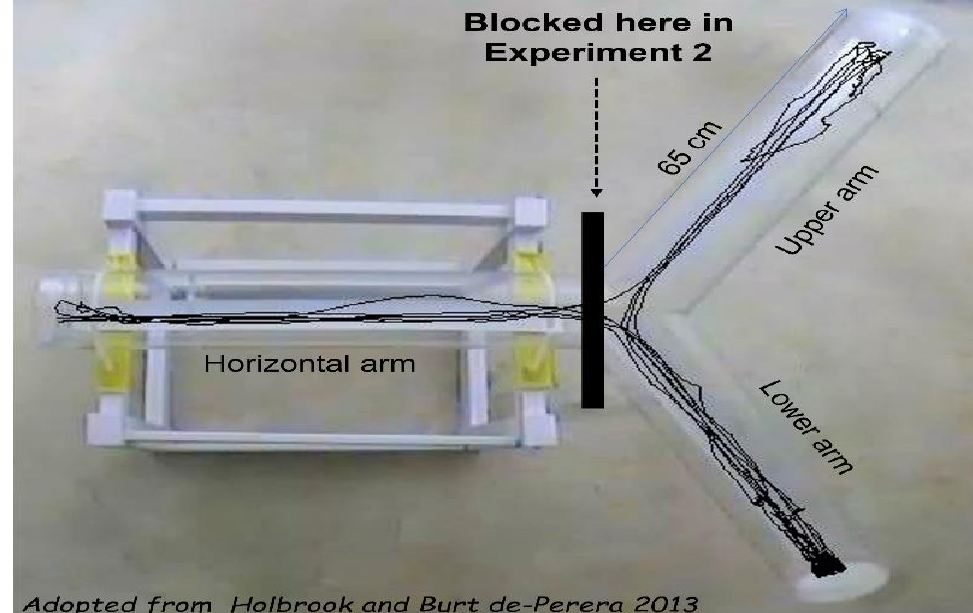
Figure 1. The apparatus. Three 65 cm transparent Plexiglas tubes (diameter: 15 cm) were connected, spaced planarly at 120°. One arm was attached horizontally to a wooden construction and could be rotated ( ‘ horizontal arm ’ ). In ‘ Experiment 1 ’ , rotation angles were: 0°, 15°,30°, 45°, and 60°. In each such rotation angle, one arm was inclined upward ( ‘ upper arm ’ ) and the other was inclined at the same angle downward ( ‘ lower arm ’ ). The upper and lower arms were sealed at the far end with a detachable plastic cover. The far end of the horizontal arm was the inlet at which the rodents were introduced to the apparatus by means of a transparent jar that remained there throughout the test. In ‘ Experiment 2 ’ , the arms were rotated to 60° and access to the horizontal arm was blocked at the arms ’ junction by means of plastic cover. In this experiment rodents were introduced into the apparatus from the far opening of the upper arm ( ‘ top-starters ’ ) or the far end of the lower arm ( ‘ bottom- starters ’ ).